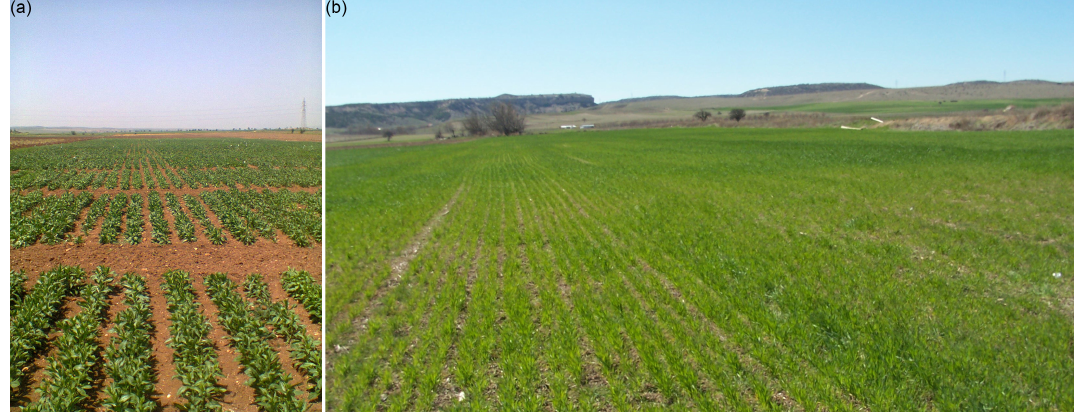
Figure 2. Scenes from the safflower (a) and wheat (b) cultivation areas. Table 1. Descriptive statistics of the soil properties. Variables Mean Minimum Maximum Coefficient of Shapiro–Wilk Total carbon % 2.10 ± 0.41 Total nitrogen % 0.15 ± 0.04 Total sulphur % Organic matter content % Aggregate stability % Clay content %